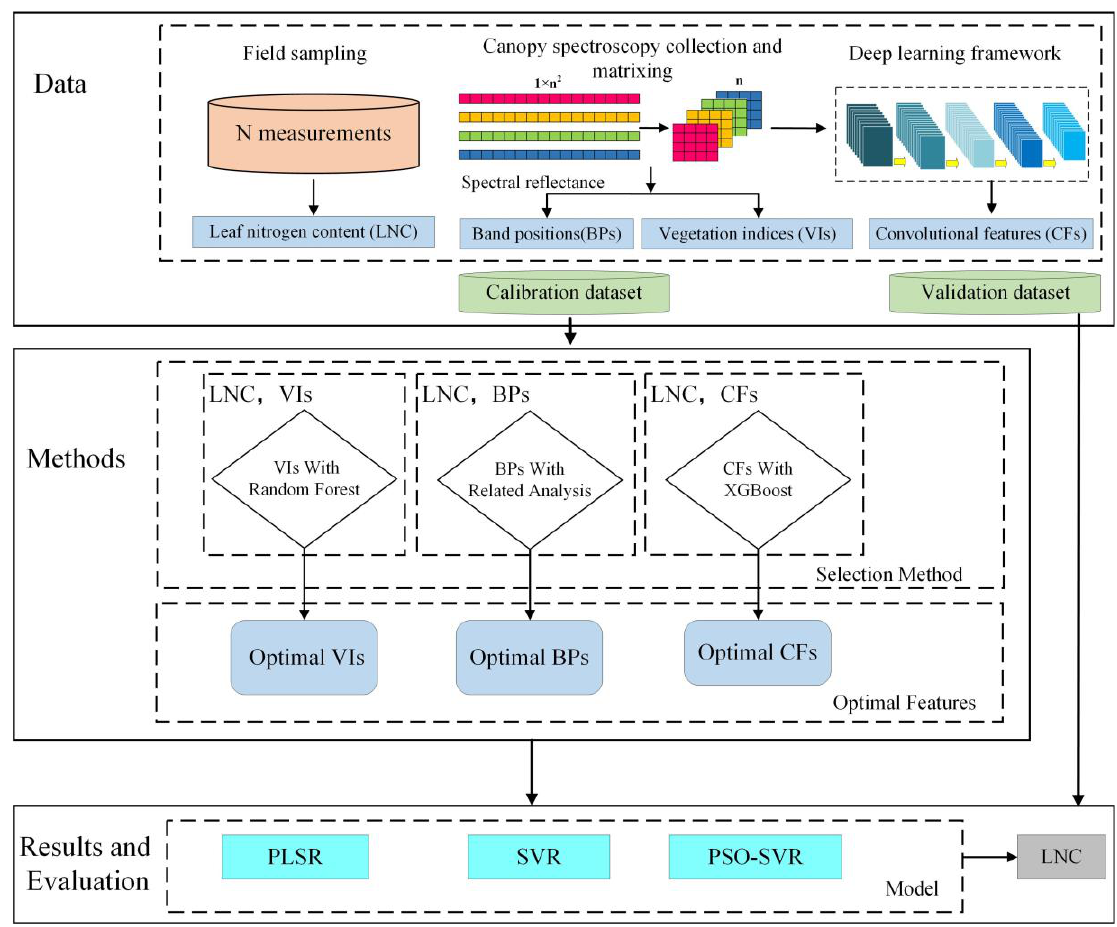
Figure 2. Technology roadmap for this study.